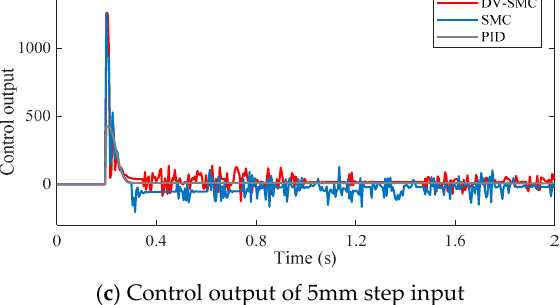
Figure 10. Control output of different reference inputs.